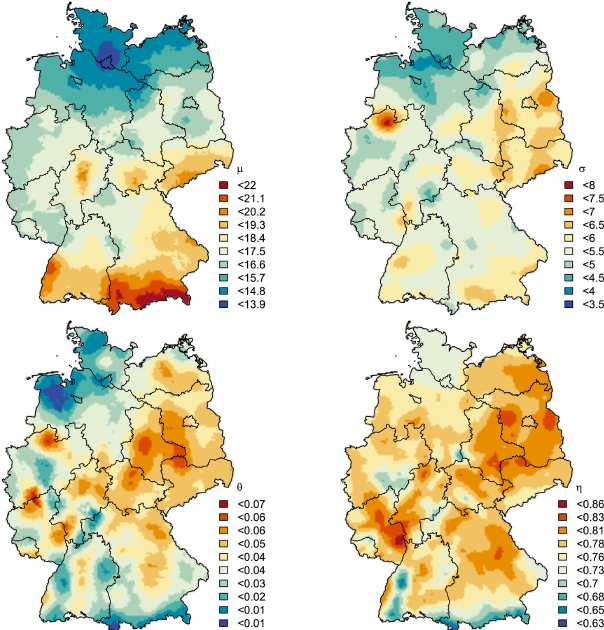
Figure 13. Obtained interpolated maps from the KED[LS | SS] for each of the parameters: location parameter µ , scale parameter σ , Koutsoyiannis θ and η parameters. The shape parameter γ is kept constant at 0.1. The black lines illustrate the borders of German federal